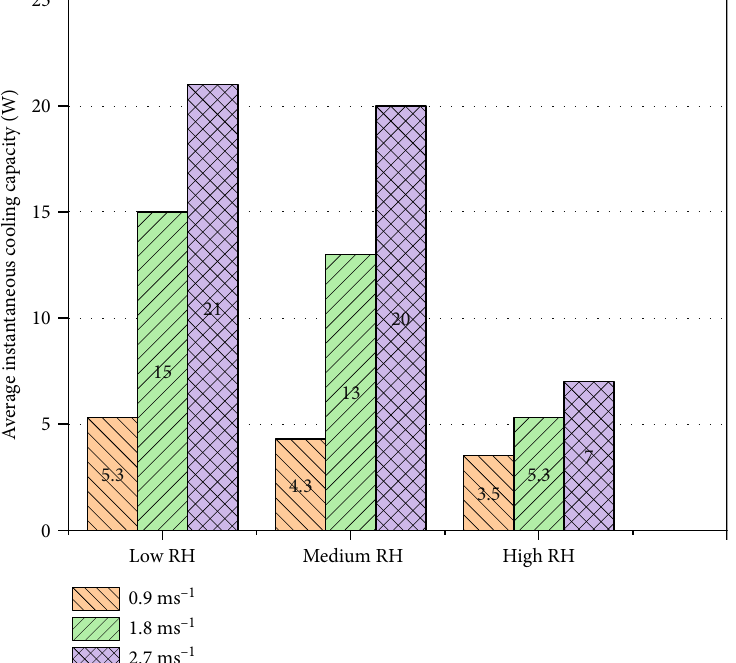
Figure 12: Average instantaneous cooling capacity of the air cooler at three di ff erent velocities under three di ff erent RH 4.3. E ff ectiveness. Figure 13 shows the e ff ectiveness calculated using Equation (2) for three di ff erent velocities under three di ff erent RH conditions. It is noticed from Figure 8(a) that